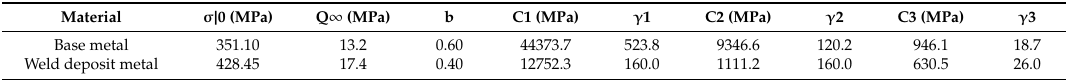
Table 9. Calculation results of ULCF life of steel bridge piers.